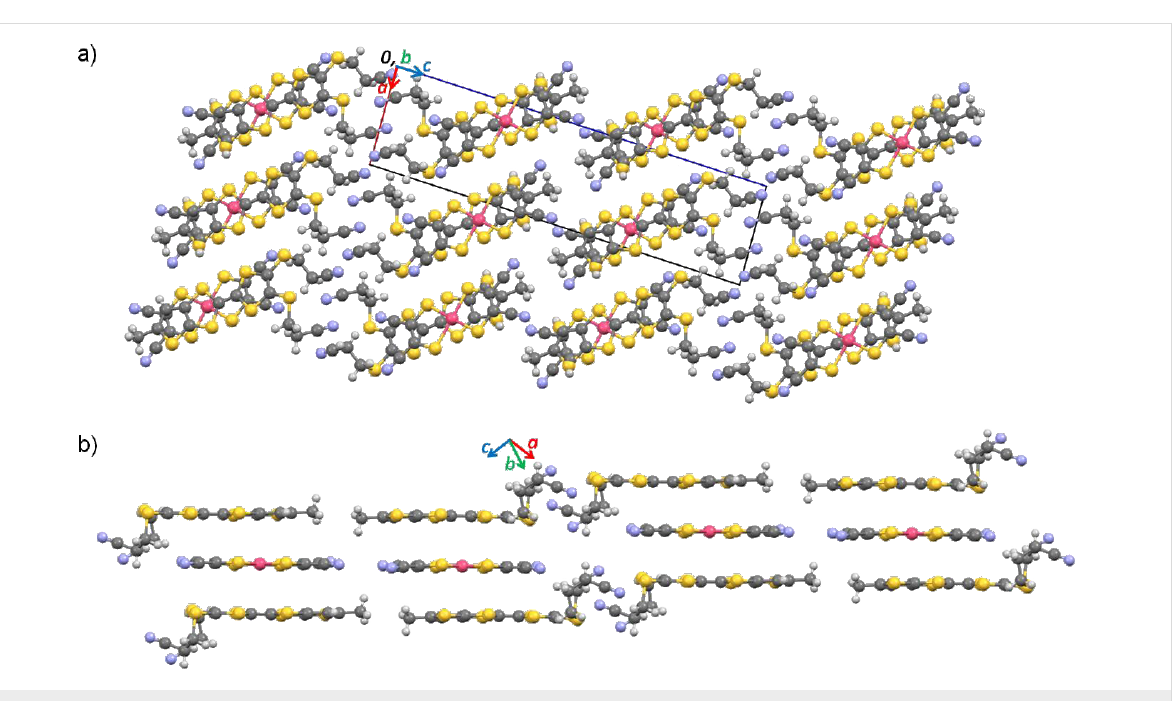
Figure 8: Crystal structure of 3 a) viewed along the b axis and b) partial view showing the alternated A–D–A–D stacks and the segregation between the methyl and cyanoethyl groups.